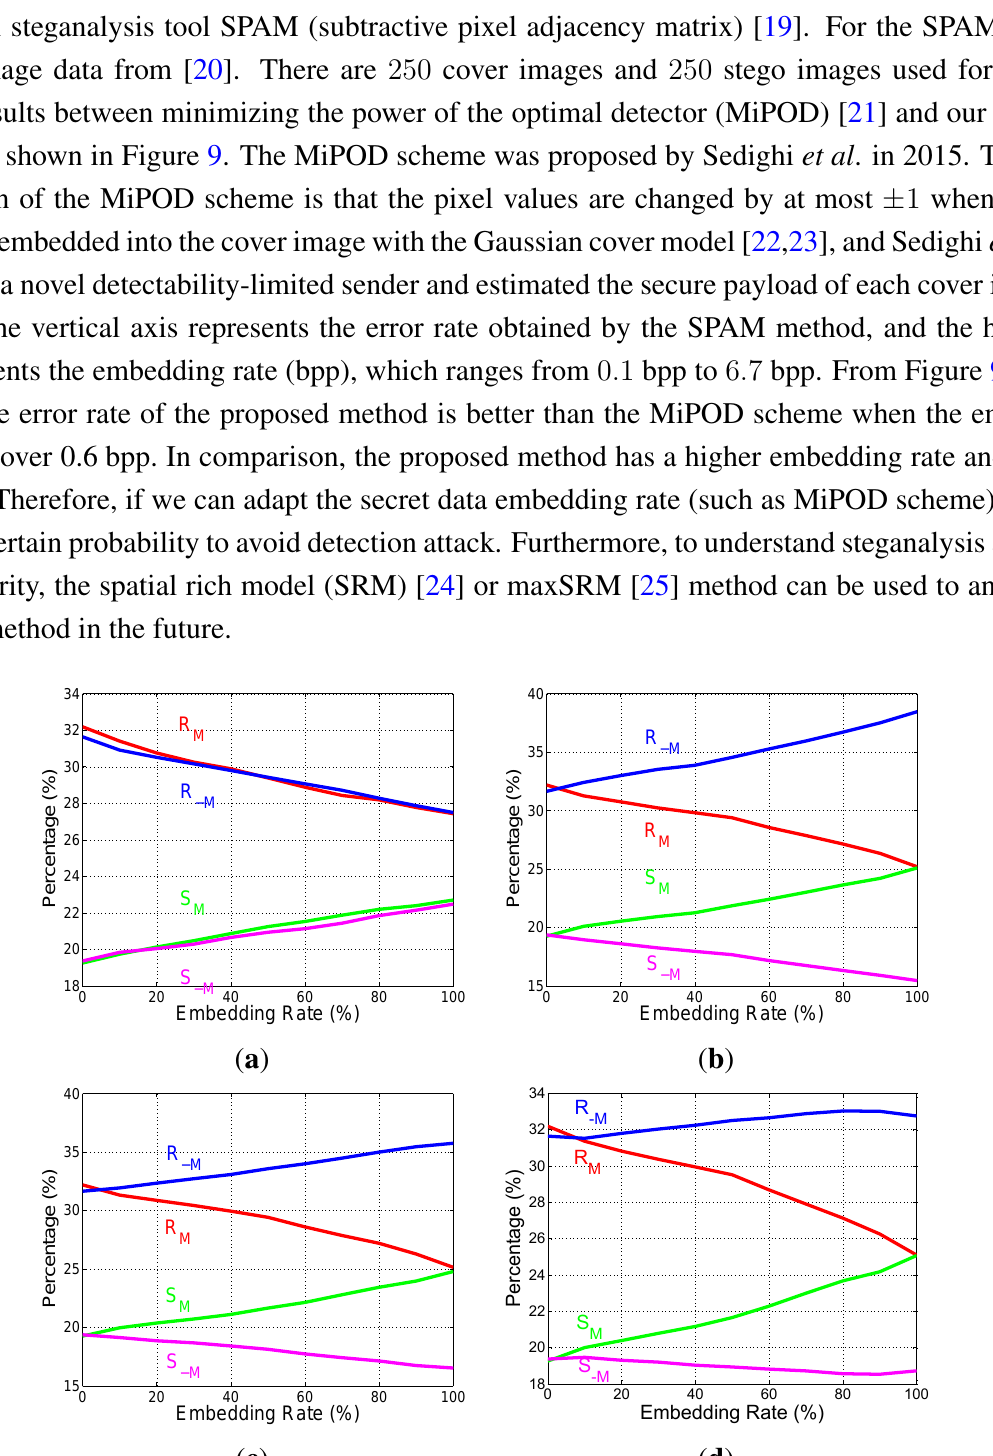
Figure 8. According to Figure 8a to 8d, the distribution of R scheme is normal, but 1 -LSB, 2 -LSB and 3 -LSB denote hidden information; because the 1 -LSB, 2 -LSB